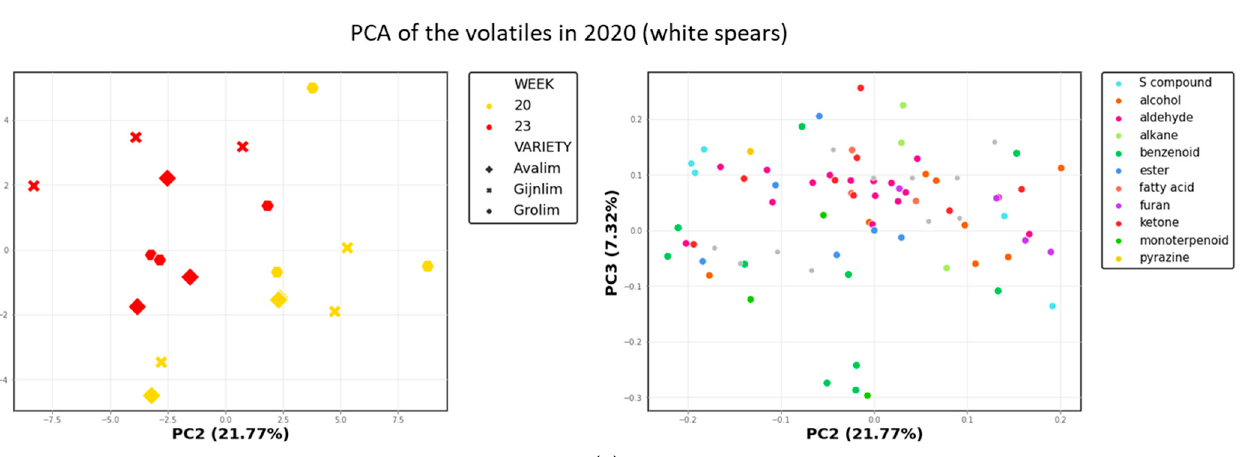
circles respectively; Figure S2: PCA of the GC ‐ MS and LC ‐ MS data of the green and white asparagus spears harvested in 2020. The first two PCs are given and the explained variance is shown in paren ‐ thesis on the plots axes. Colours indicate the compound class of the identified metabolites. Uniden ‐ tified compounds are coloured grey: (a) Loading plot of the volatile profiles; (b) Loading plot of the non-volatile profiles; Figure S3: PCA of the 61 identified volatiles detected in the green and white asparagus spears harvested and analysed in 2019 and 2020. Data were log-transformed and autoscaled before fusing them: (a) Score plot of the first two PCs where the explained variance is shown in parenthesis on the plots axes. Colours indicate the asparagus type, symbol shapes indicate asparagus variety; (b) Loadings of the first PC sorted in descending order; Figure S4: Schematic representation of the composition of a pooled sample produced for the analysis of the asparagus varieties. For each pooled sample of three spears, the shoots were cut into 2 cm sections: (a) one piece per section (X) was taken across three spears to generate a pooled biological replicate sample representative of a whole spear; (b) for the spatial metabolomics pilot, the equivalent pieces from three spears were collected to make pooled samples per section. The numbers given in (b) correspond to the annotations in Figure 5; for green spears, 5 sections are shown as green shoots were shorter than white asparagus (Figure 1).